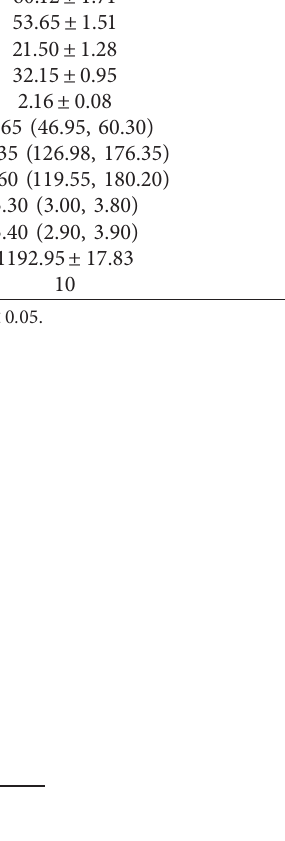
Figure 1: Mean serum irisin level in controls and severe hypothyroidism patients with (HT-B) or without (HT-A) pericardial effusion. ∗ ∗ P < 0 . 01.